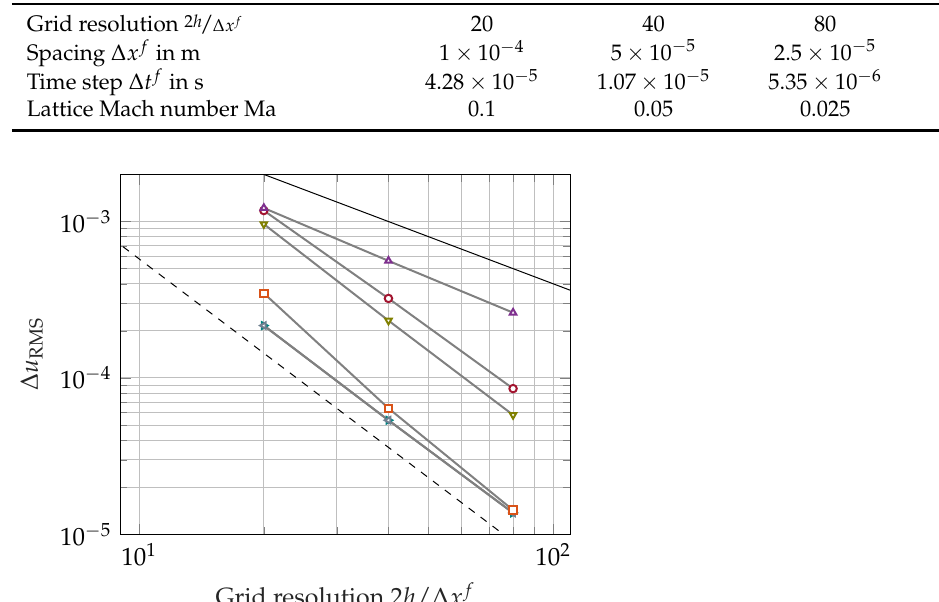
Table 3. Summary of grid parameters for convergence study with ˜ ω c = 1.94990 (Re h , b = 67.53).